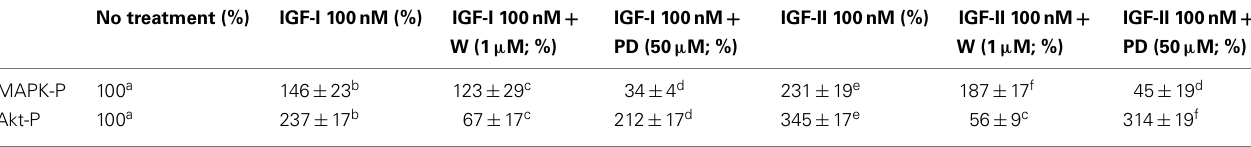
Table 1 | Effect of inhibitors on the MAPK and PI3K–Akt pathways in IGF-I or IGF-II treated sea bream myocytes. No treatment (%)